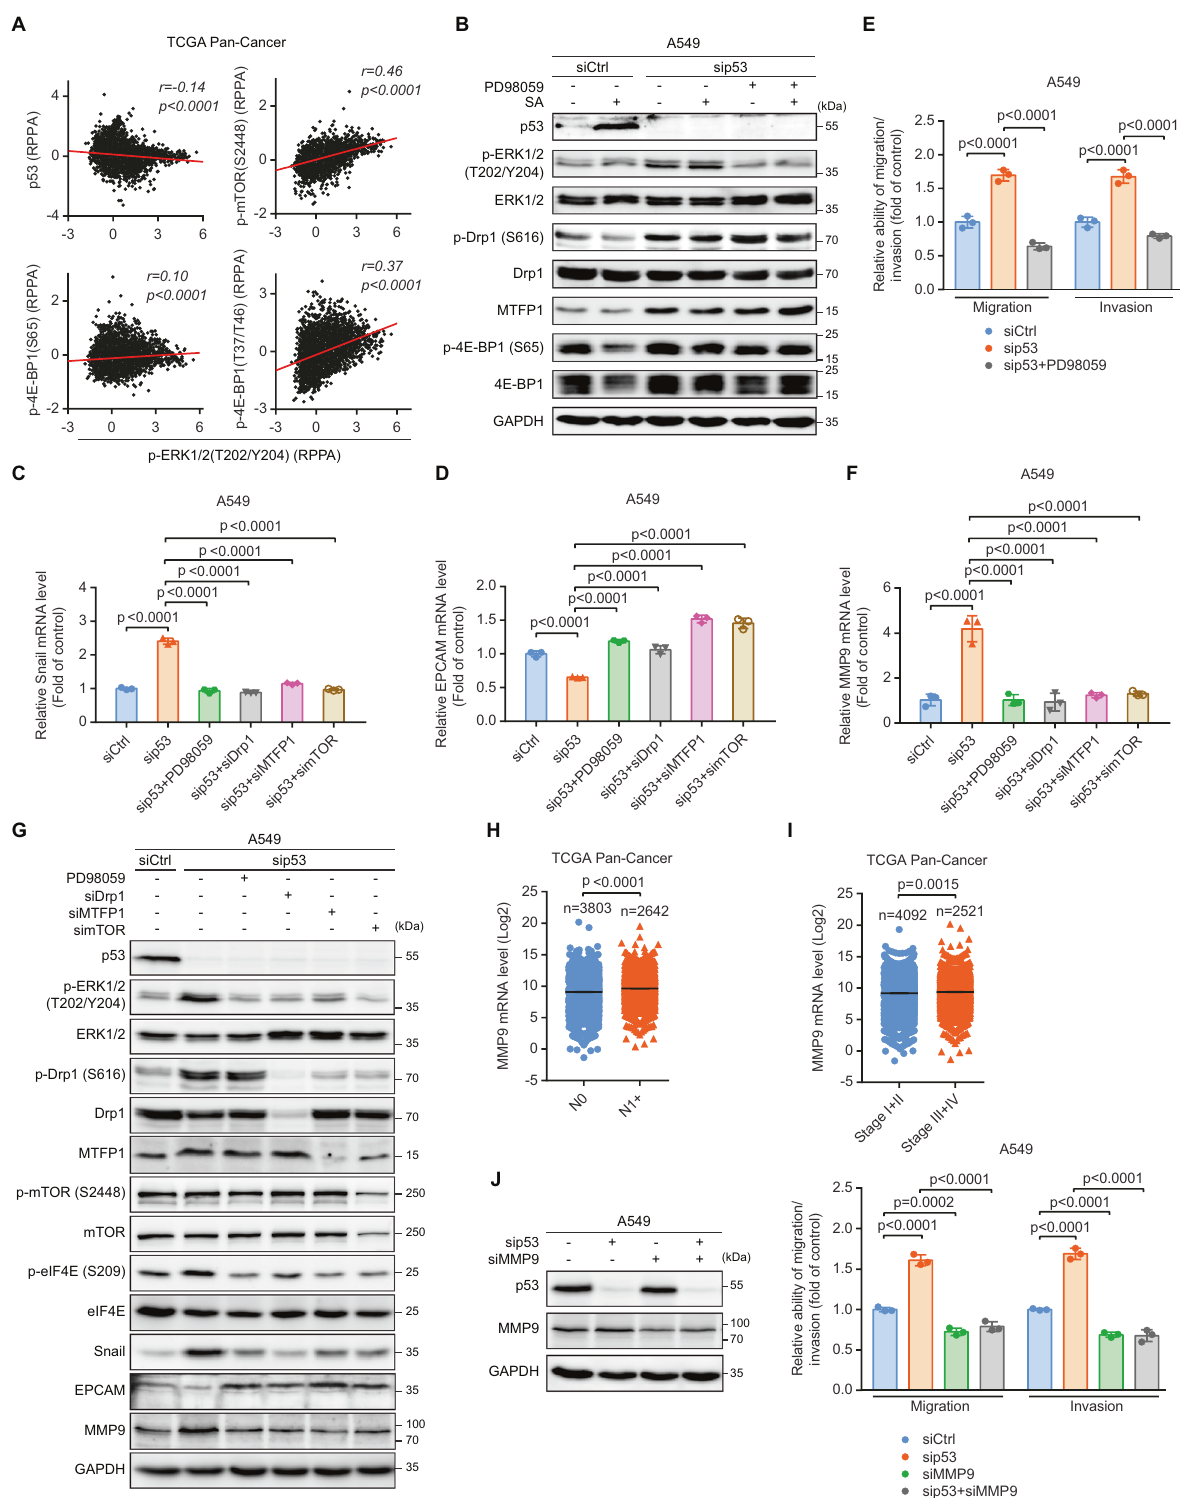
Several studies have highlighted that ERK1/2 activation stimulates the expression of MMP9, which contributes to the proteolytic degradation of the extracellular matrix [36 – 40]. Strikingly, p53 silencing induced approximately 4- and 4.4-fold increases in MMP9 mRNA levels in A549 (Fig. 6F) and MCF-7 (Fig. S5D) cells, respectively. Inhibition of ERK1/2 or co-knockdown of Drp1, MTFP1, or mTOR completely abolished increased